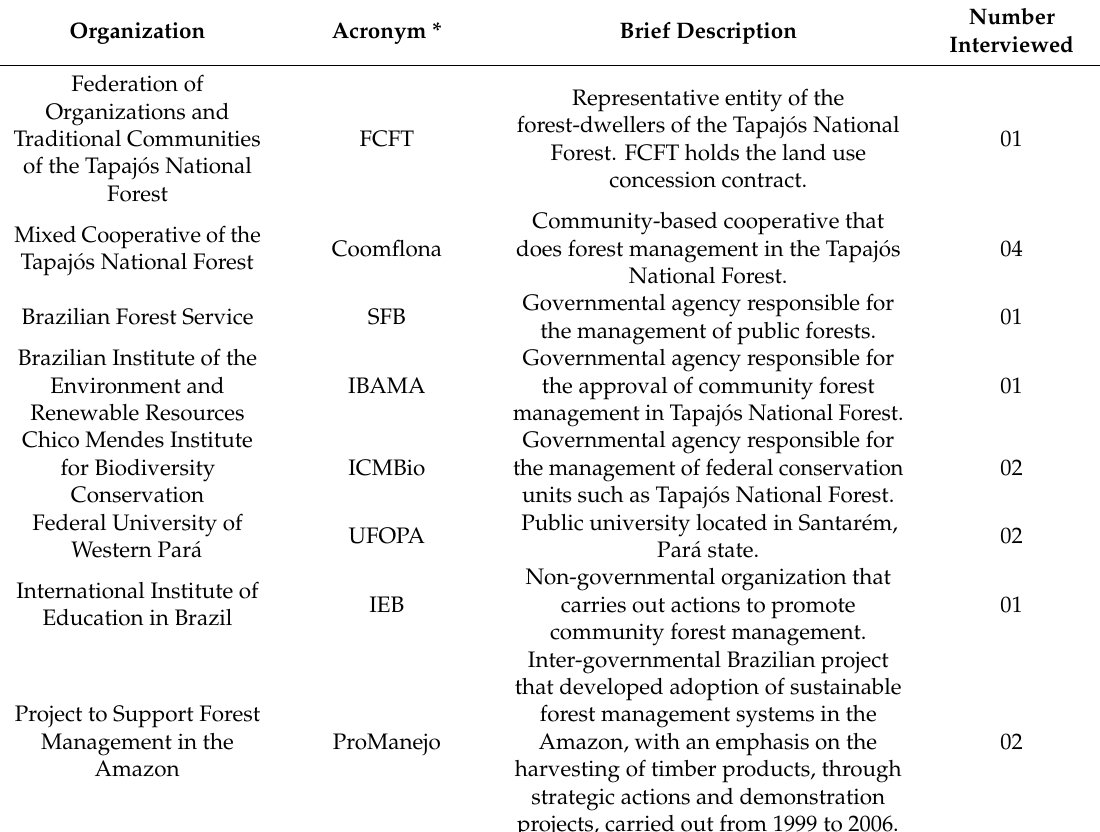
Table 1. List of organizations interviewed, a brief description of the organization, and the number of organization members